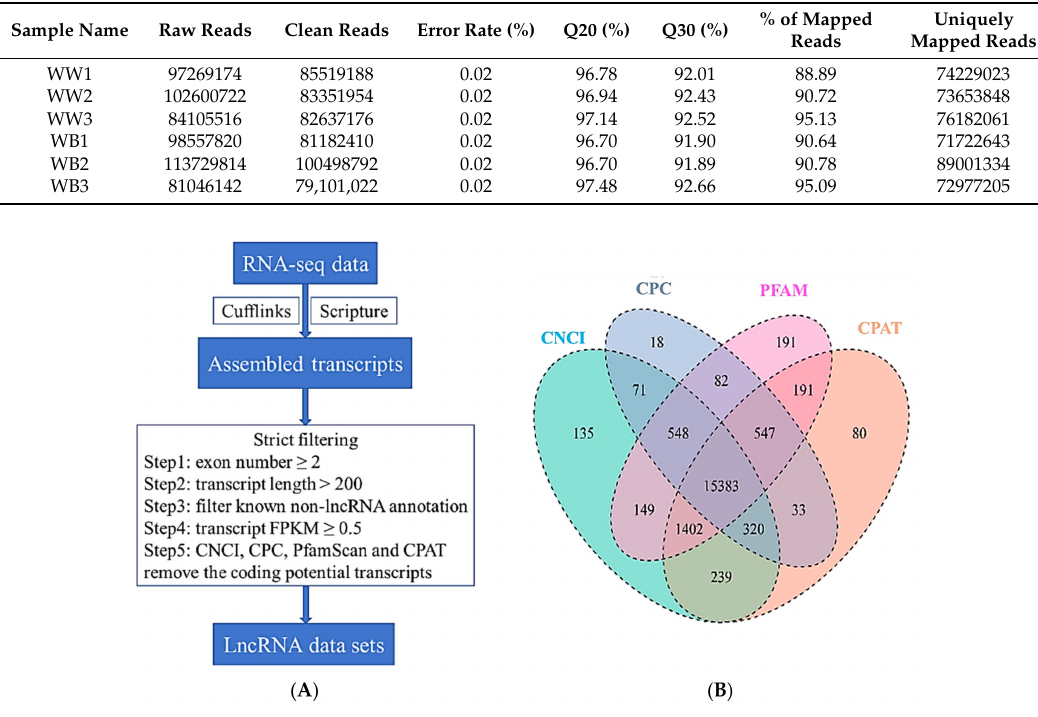
Figure 2. Identification of long non-coding RNAs (lncRNAs) in skin transcriptome. ( A ) Workflow for lncRNA identification. ( B ) Candidate lncRNAs were identified by using four applications: CNCI (coding-non-coding-index), CPC (coding potential calculator), PFAM-scan v1.3 and CPAT (coding potential assessment tool) which detect and remove putative protein-coding